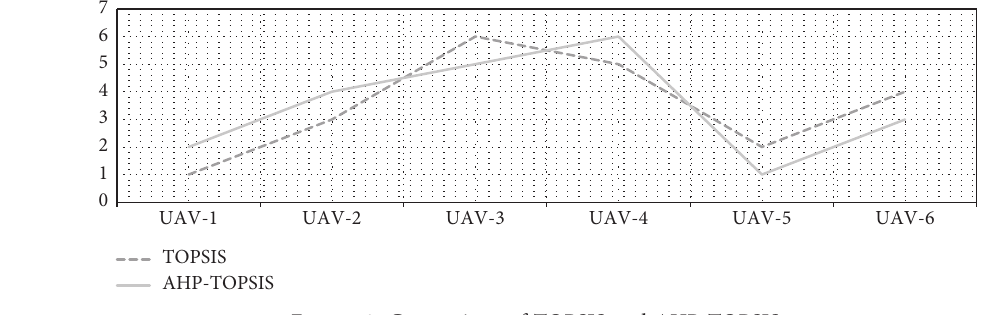
Figure 3: Comparison of TOPSIS and AHP-TOPSIS. Table 8: Comparison of company ranking approaches.